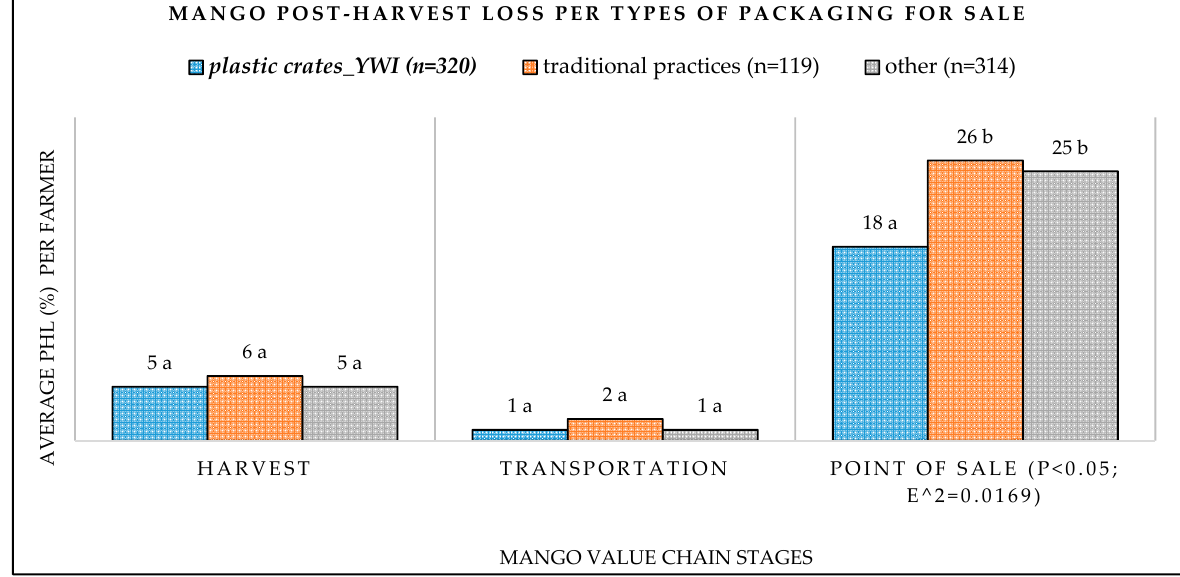
Figure 5. Comparing plastic crates to traditional practices. Values with different letters are significantly different at p < 0.05 from the Kruskal–Wallis analysis, Dunn test, and Benjamini–Hochberg adjustment. E^2 = Epsilon-squared value for effect size. YWI refers to the technology that the Yieldwise Initiative promoted. ( n ) refers to the number of farmers who reported using a given practice or technology. ‘Other’ refers to practices that combined both YWI promoted technologies and traditional